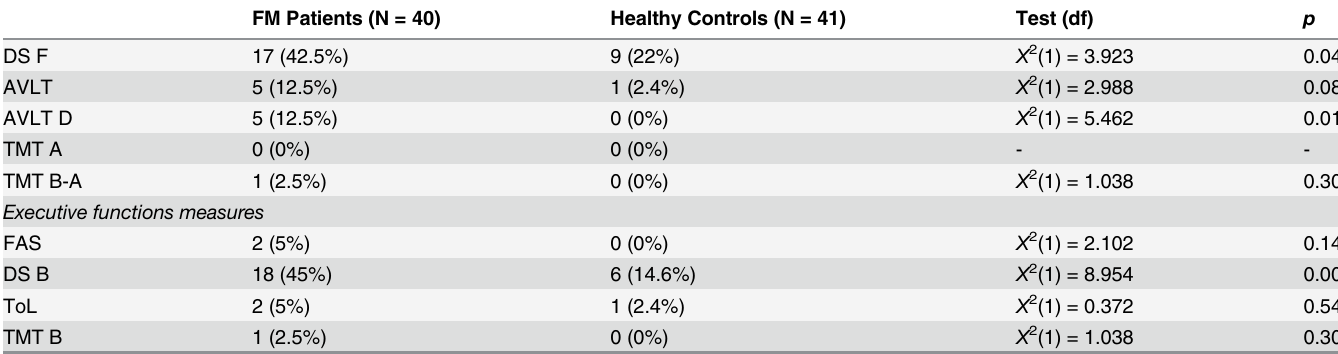
Table 3. Number and percentage of patients with FM and healthy controls with impaired or borderline performance (E.S. = 0 – 1) at neuropsychological measures. FM Patients (N =